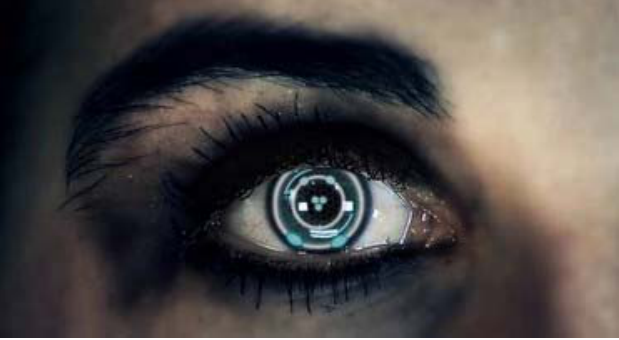
Figure 9. An example of cyborg eye. Source: https://www.behance.net/gallery/4411227/Cyborg-Eye-(Female).